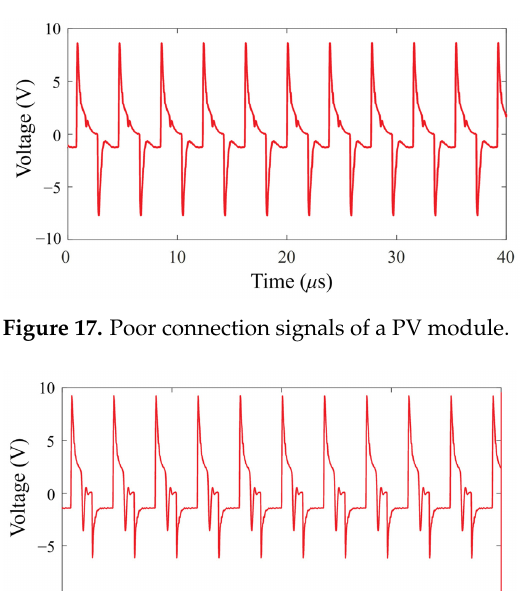
Figure 16. Normal signals of a PV module.